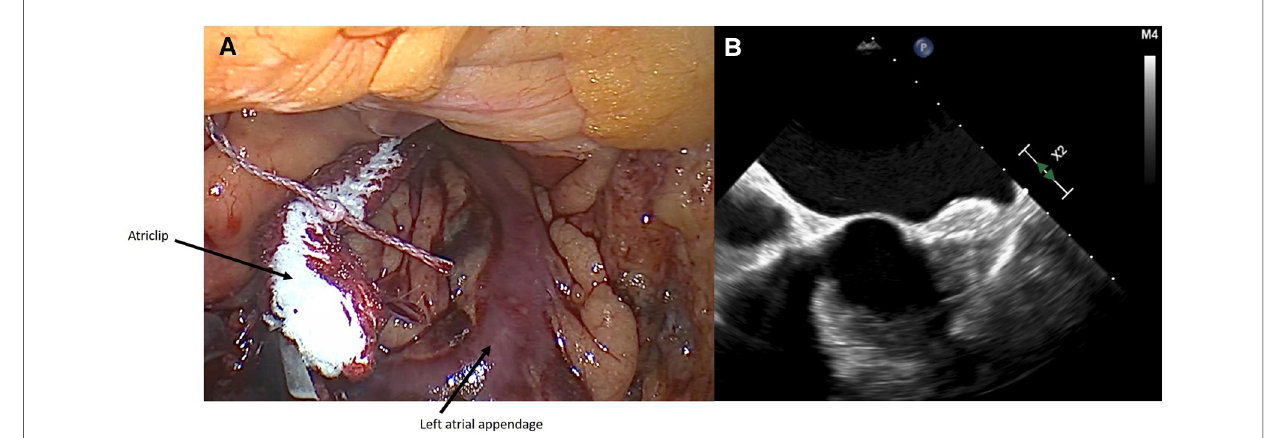
FIGURE 2 ( A ) intraoperative closure of LAA with AtriClip PRO2 ® device. ( B ) Intraoperative transesophageal echocardiography showing successful closure of LAA.